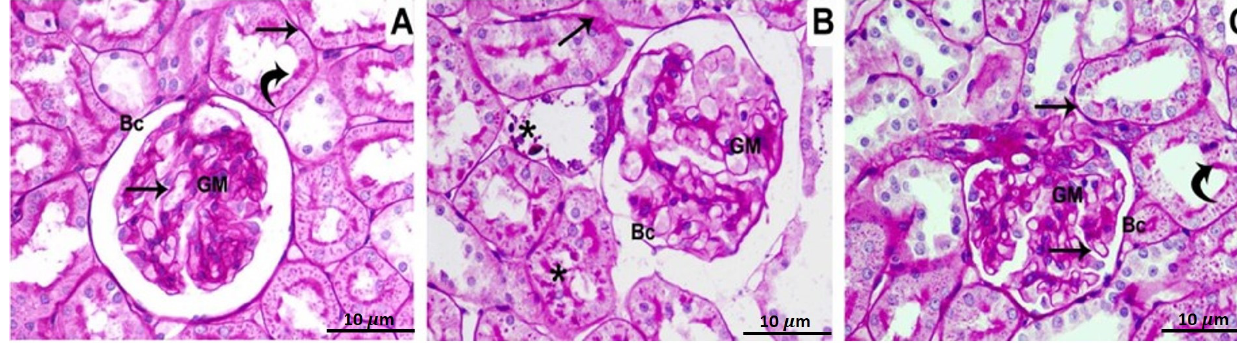
Figure 1. Photomicrographs of the renal cortex stained with PAS show, Control group ( A ): The glomerular and tubular basement membranes (arrows), glomerular matrix (GM), and the brush border of the proximal convoluted tubules (curved arrows), all showed a strong PAS-positive reaction; ( B ) BPA-treated group: the tubular basement membrane (arrow) thickening, elevated PAS positivity in the mesangial matrix (GM), and damage of the renal tubule brush border (stars); ( C ) BPA and ATX-treated groups have thin glomerular and tubular basement membranes (arrows), with normal mesangial matrix deposition (GM). The brush border of the renal tubules has a PAS-positive reaction (curved arrows). Bowman’s capsule was pointed out by BC. 10 µm scale bar.